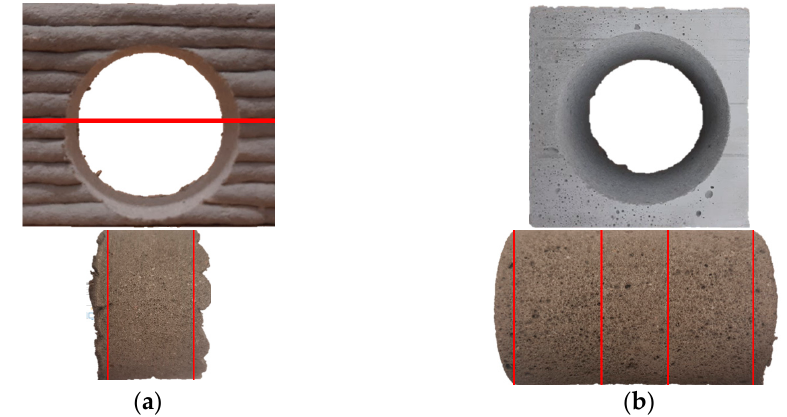
Figure 4. Extraction of 70 mm diameter DI test discs from ( a ) printed samples with the CL indicated in thick red, and ( b ) reference cast samples. Both printed and cast samples were saw-cut to 30 mm thickness, as indicated by thin red lines. Table 4. WSI and CCI testing deviations.